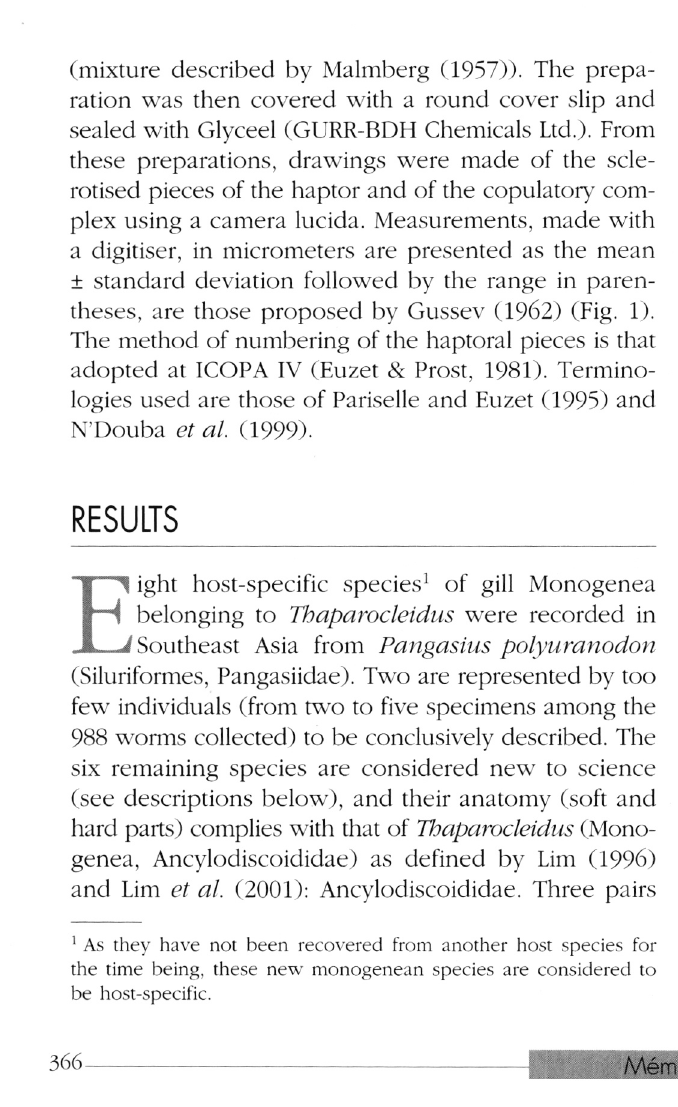
Fig. 1. - Measurements used in this study. C - cuneus: L = length; 1 = largest width; e = extension length. DB = dorsal transverse bar: x = total length; w = width in the middle. DG = dorsal gripus: a, b, c, d and e = standard measurements. MA = male apparatus: Pe = total length of the penis; Ap = length of the acces­ sory piece; He = length of the heel. U = total length of the uncinuli. VB = ventral transverse bar: x = length of one branch; w = largest width. VG = ventral gripus: a, b, c, d and e = standard measurements; L and 1 = length and width of gripus aperture. V = vagina: L = total length; 1 = maximum